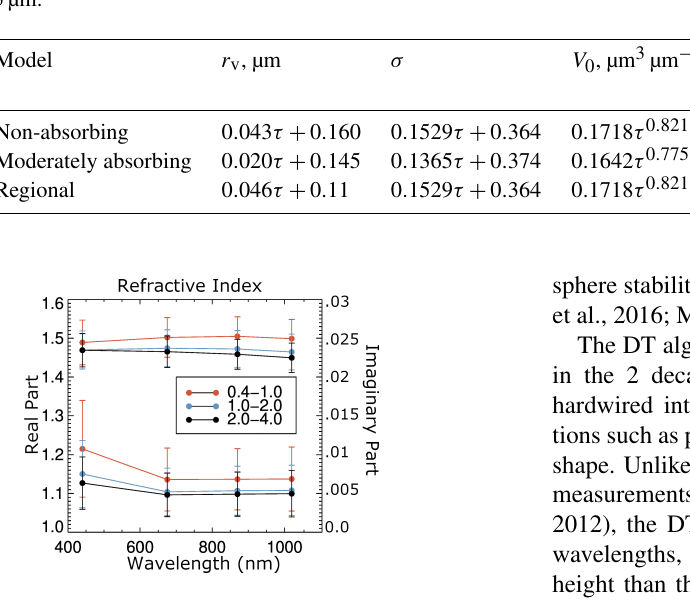
Figure 6. The real (top set of curves and left axis) and imaginary (lower set of curves and right axis) parts of the refractive index as a function of AOD at 0.675µm calculated from the AERONET in- version product at cluster 1. The error bars represent the standard deviation within each